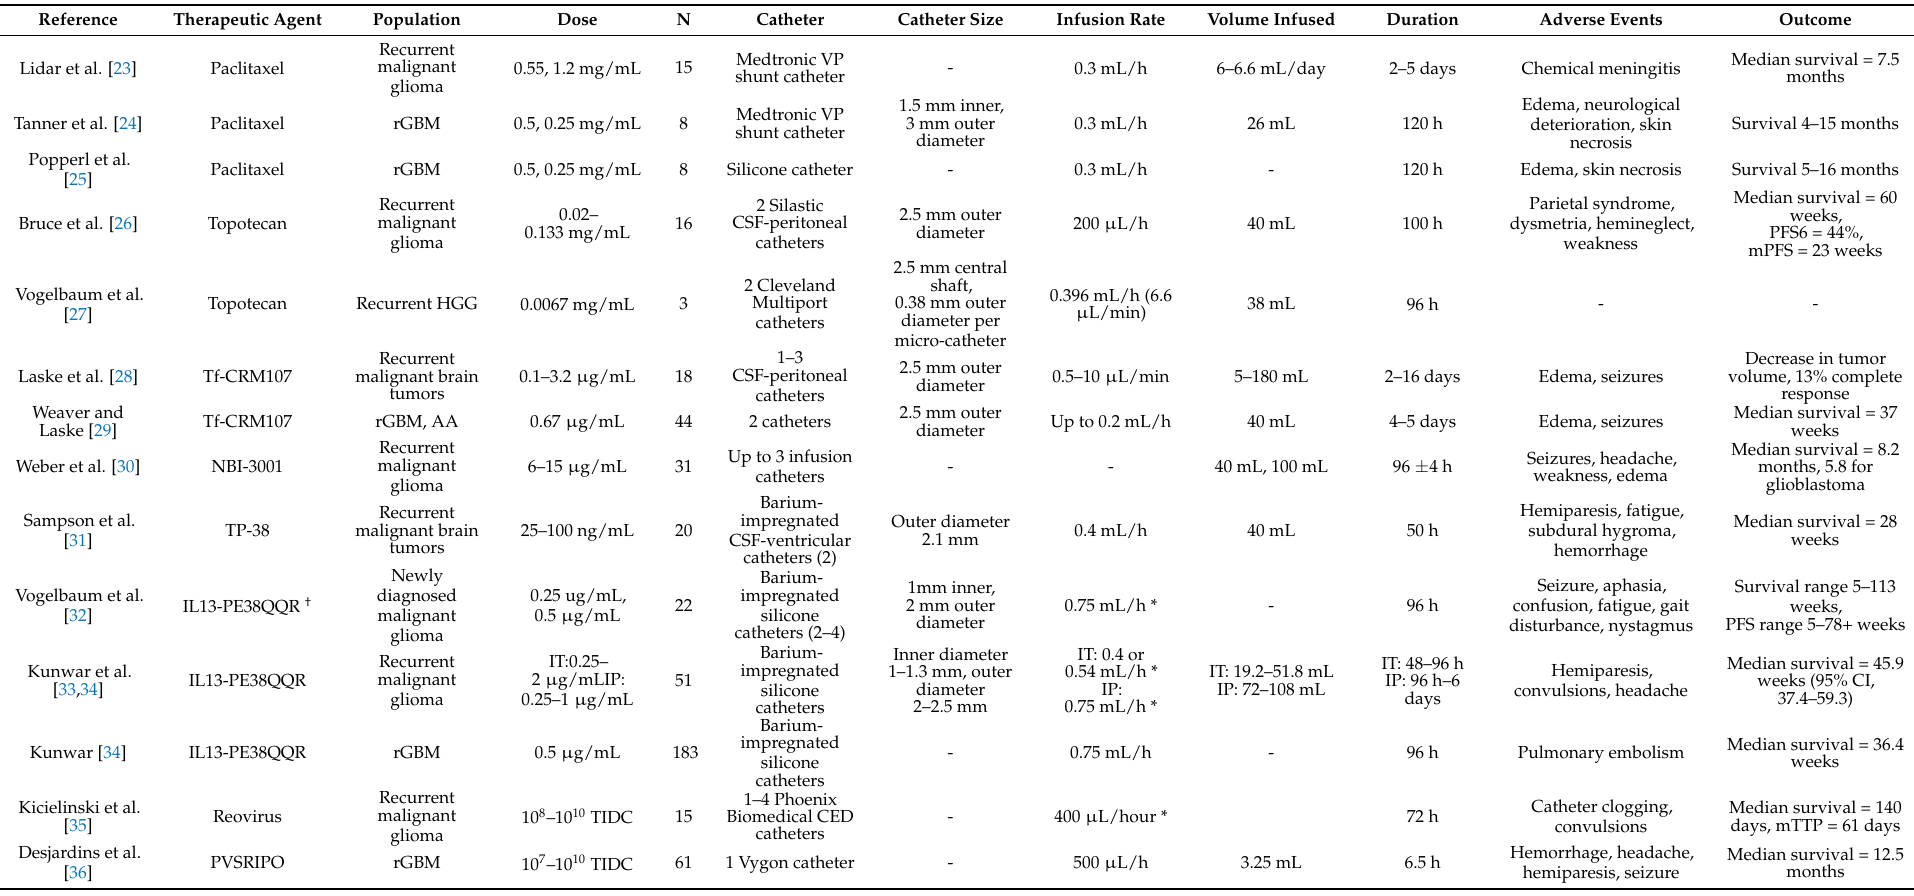
Table 1. Completed clinical trials utilizing CED to deliver similar